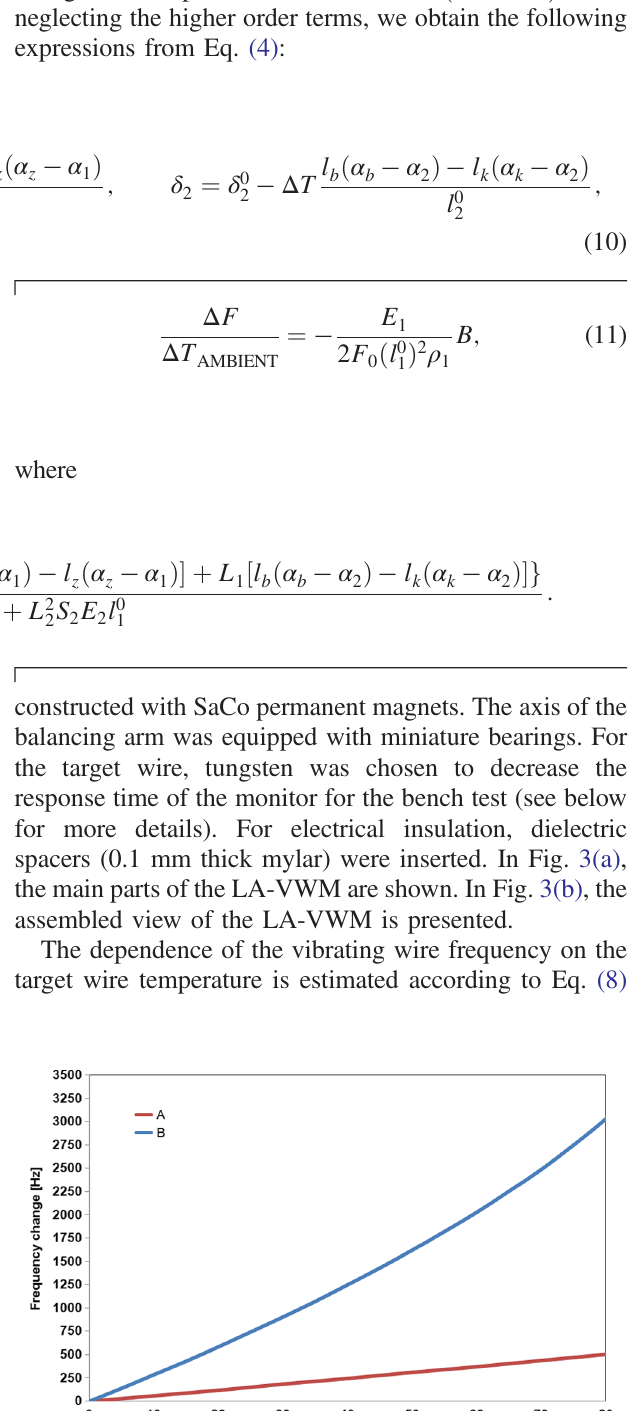
FIG. 3. (a) Main parts of the LA-VWM: 1: vibrating wire; 2: target wire; 3: round magnets providing the magnetic field for wire oscillation generation. (b) Assembled view of the LA- VWM. The space to the right of the balancing arm support is free for beam measurement (in comparison with the previous model of the VWM in Fig. 1).